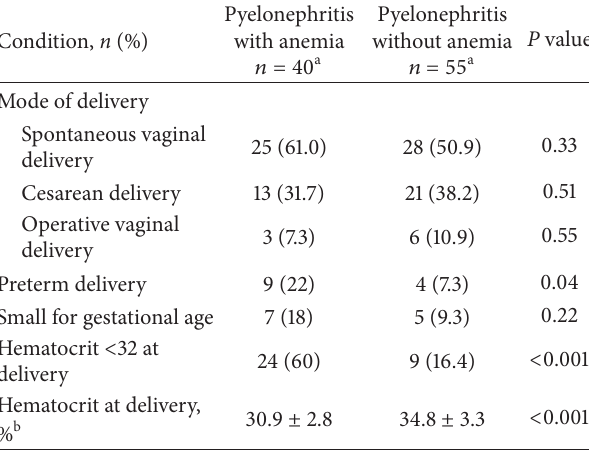
Table 4: Obstetric events present at time of